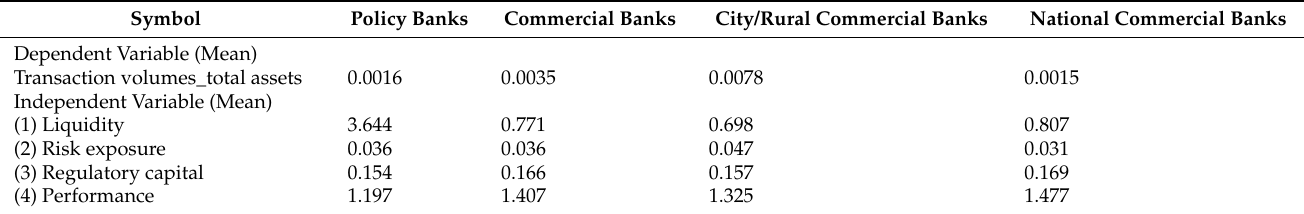
Table 4. Bank-specific determinant variable comparison (pre-2017Q4).